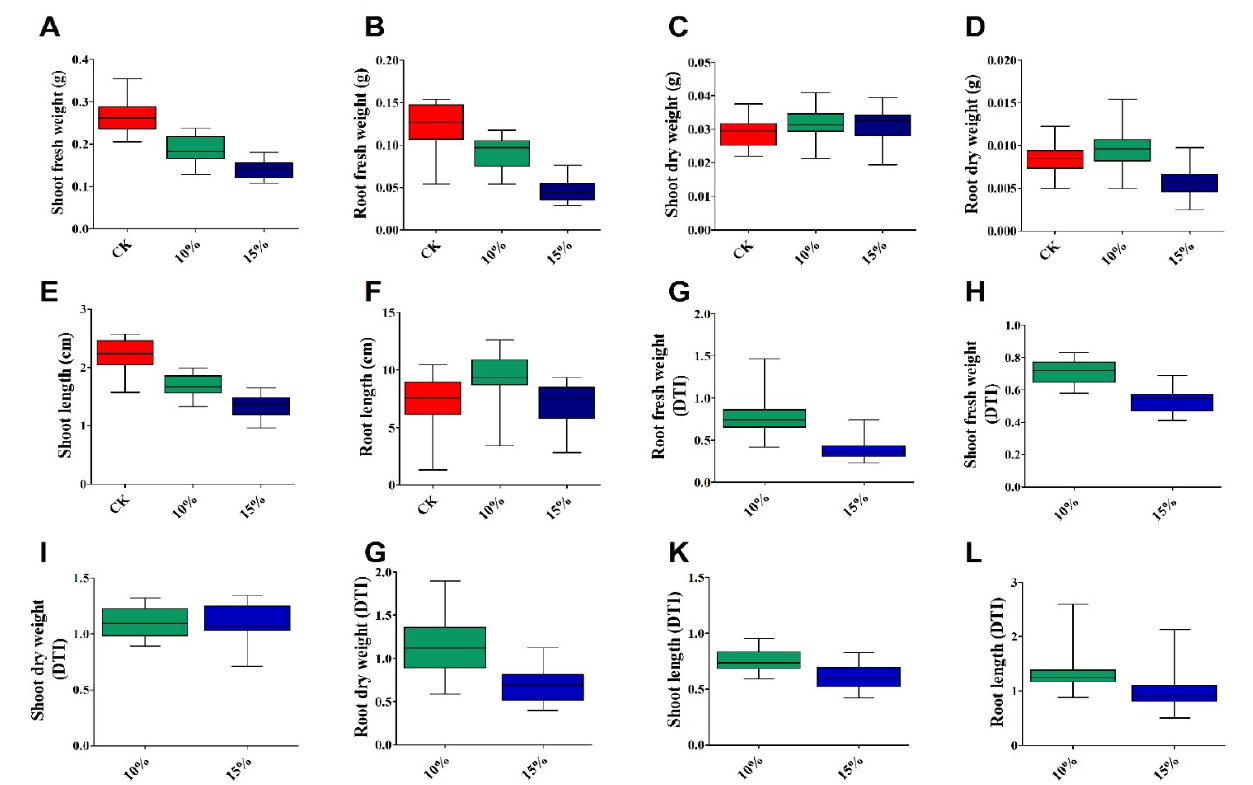
respectively (Table 2).